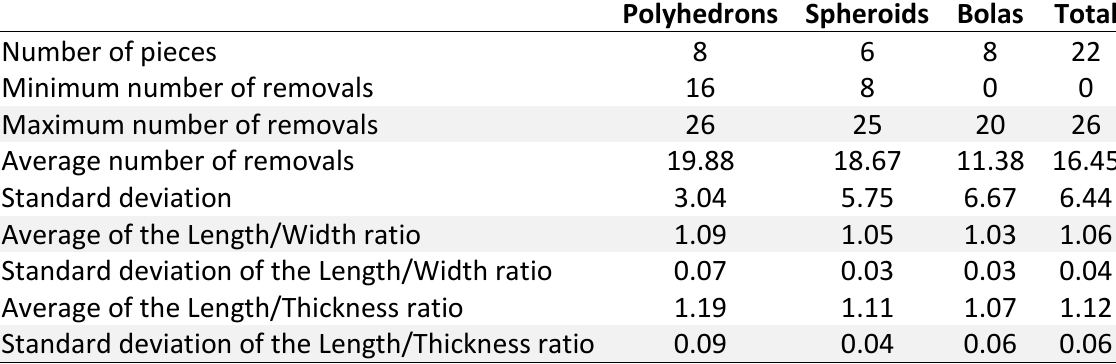
Table 2. Number of removals, Length/Width and Length/Thickness ratio (cm), for polyhedrons, spheroids and